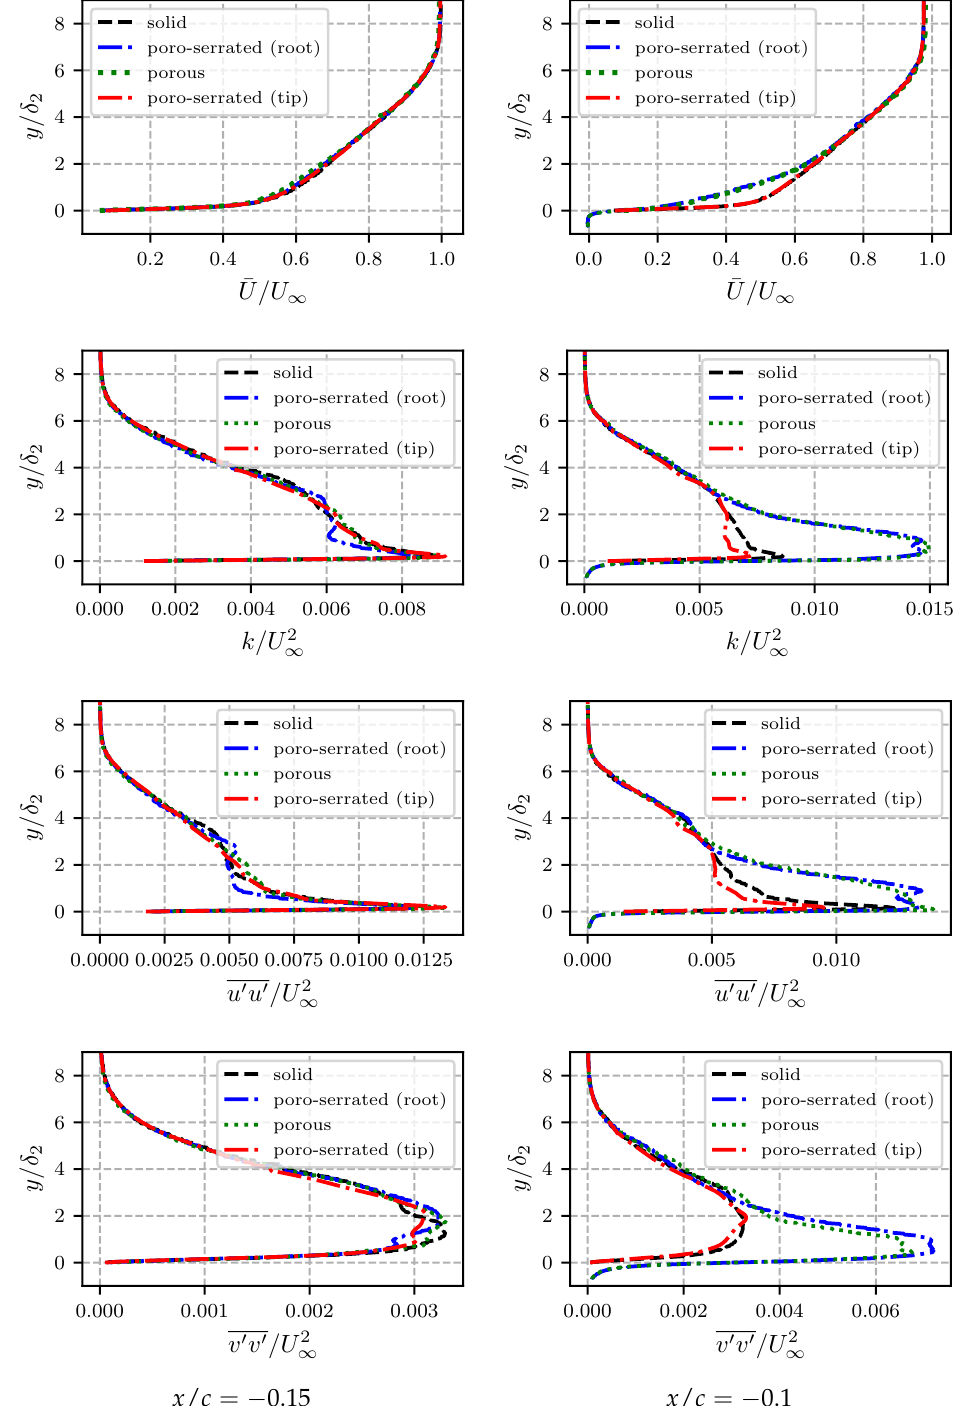
Figure 8. Wall-normal profiles of the mean streamwise velocity, turbulent kinetic energy, and the streamwise and wall-normal Reynolds